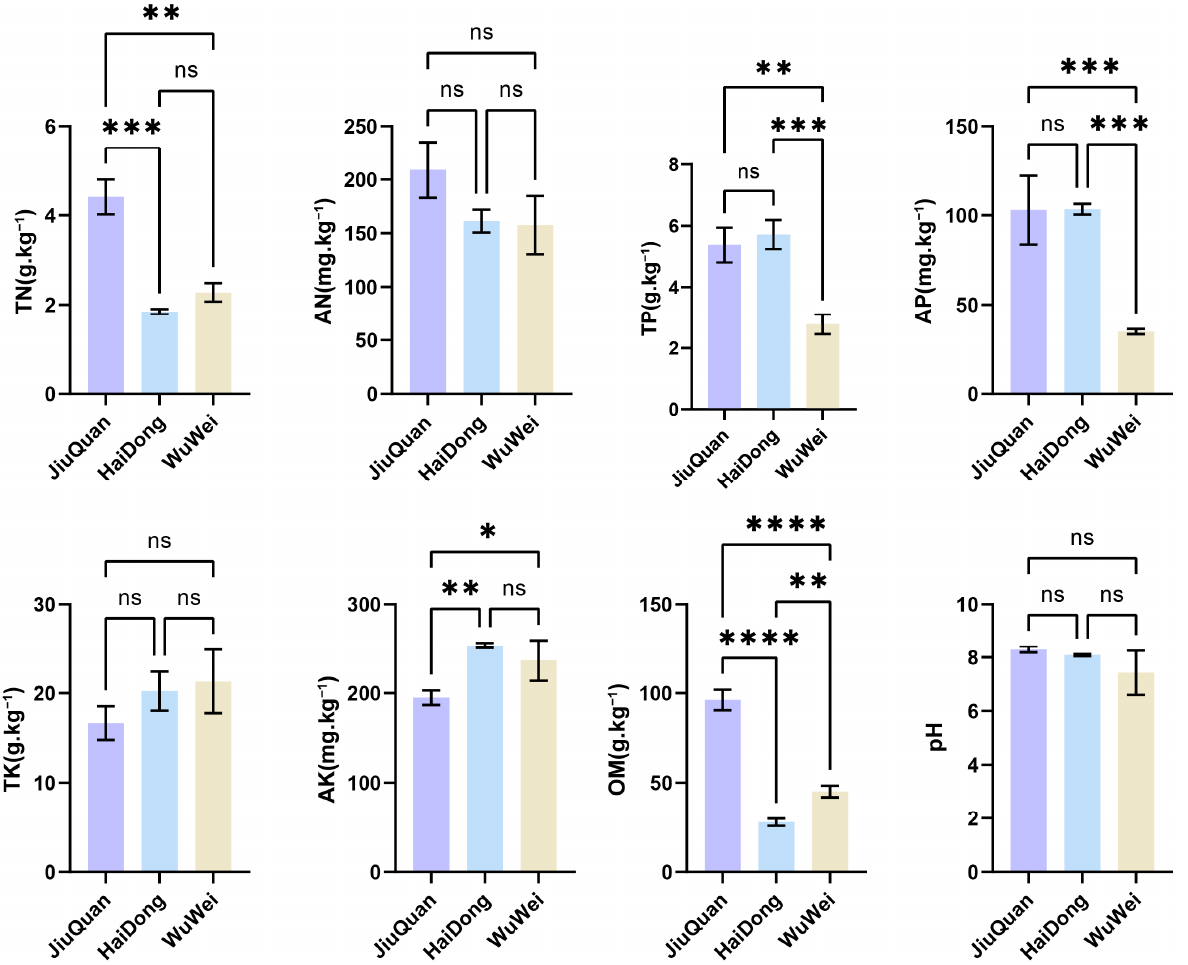
Figure 7. Differences in soil nutrients between the regions, p > 0.05(ns), p < 0.05(*), p < 0.01(**), p < 0.001(***), p <